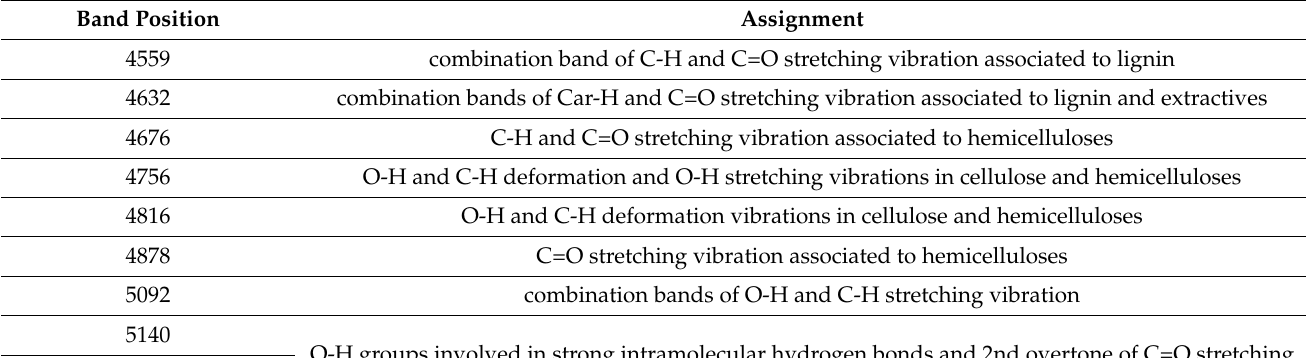
4878 C=O stretching vibration associated to hemicelluloses 5092 combination bands of O-H and C-H stretching vibration 5140 O-H groups involved in strong intramolecular hydrogen bonds and 2nd overtone of C=O stretching vibration mainly in hemicelluloses5216